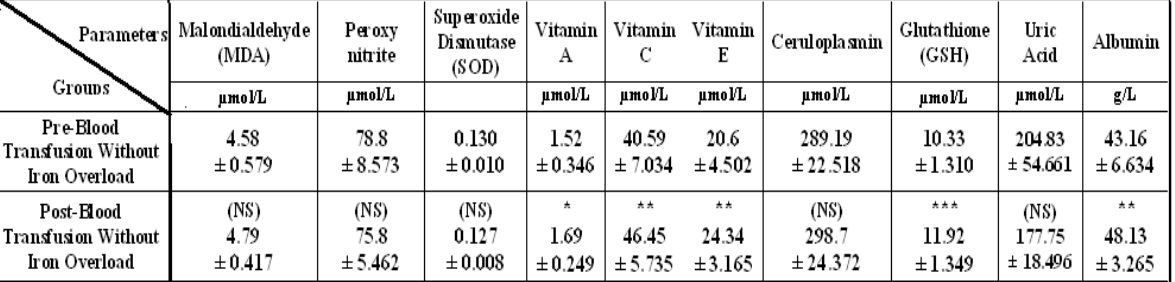
Table 1: Effects of blood transfusion in thalassemic patients, without iron overload, on lipid peroxidation and antioxidant status.